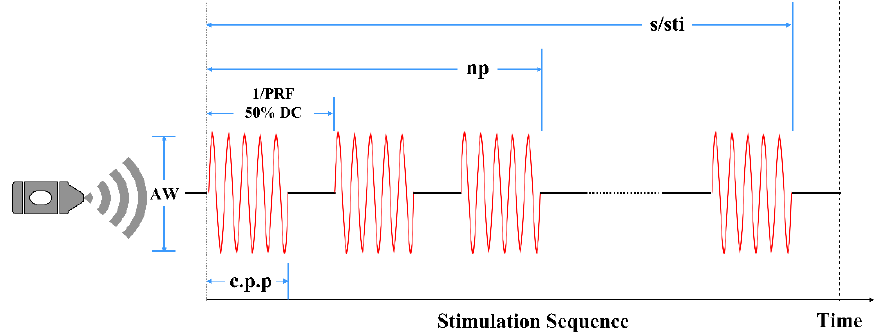
Figure 4. Pulsed ultrasound waveform generation with the following properties: Af = 0.5 MHz, c.p.p. = 150, PRF = 1.5 kHz, np = 200.